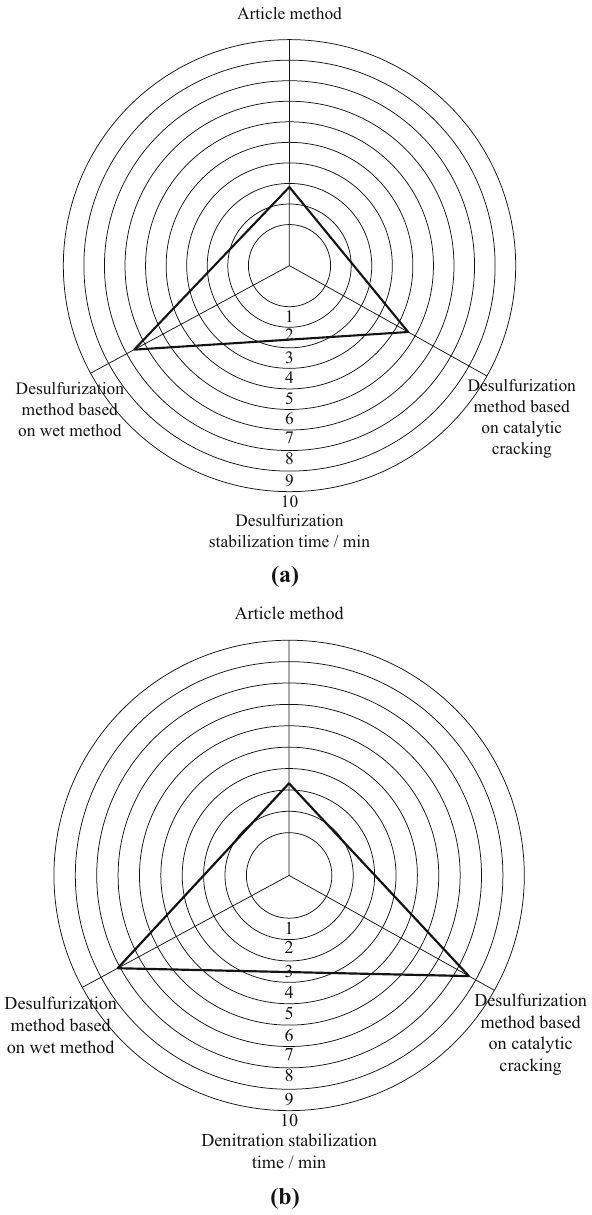
Figure 7: E ffi ciency comparison of di ff erent methods. ( a ) Desul - furization e ffi ciency. ( b ) Denitration e ffi